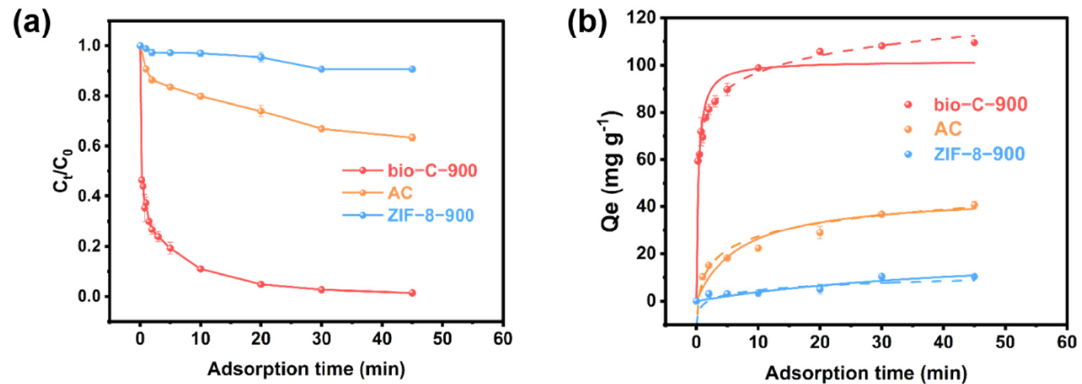
Figure 6. ( a ) Adsorption kinetics curves of all materials for SMX in this study; ( b ) The corresponding pseudo-second-order adsorption kinetic model and Elovich kinetic model were fitted. Reaction con- ditions: initial concentration of SMX = 10 mg/L, reaction volume = 50 mL, catalyst dosage = 4.5 mg, initial solution pH = 7, temperature = 25 °C, reaction time = 45 min. Table 4. Langmuir and Freundlich adsorption isotherm model. Langmuir Model